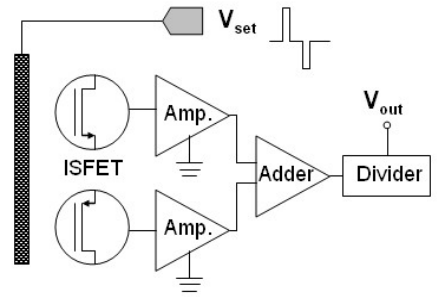
Figure 7. The schematic diagram of the proposed system and measurement method.